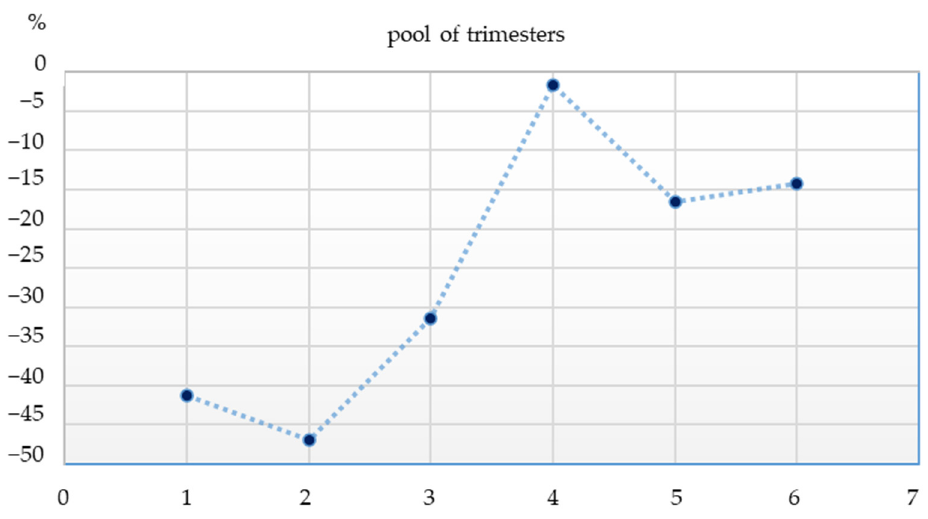
Figure 1. Quarterly comparison of CD diagnoses in the pre-COVID-19 period (pool of trimesters